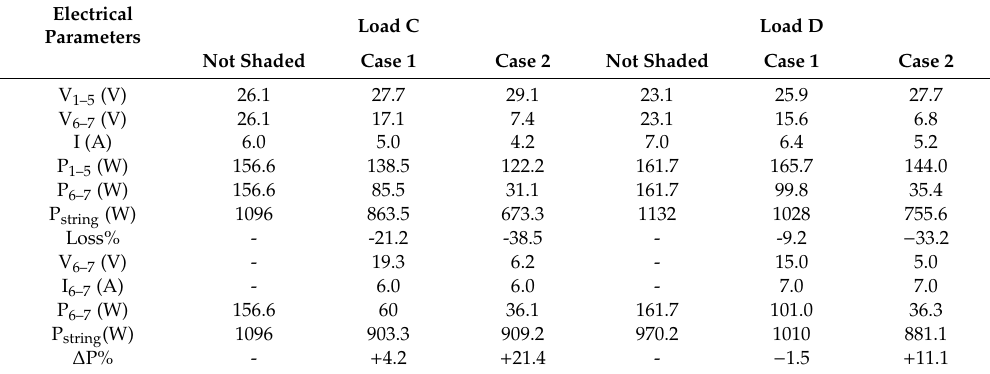
Table 13. Electrical characteristic of the string in di ff erent shadow